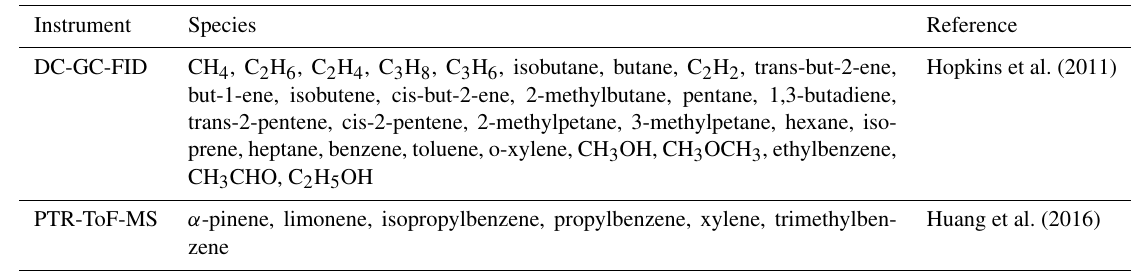
Table 2. The species measured by DC-GC-FID and PTR-ToF-MS that have been used as constraints in the model. Instrument Species